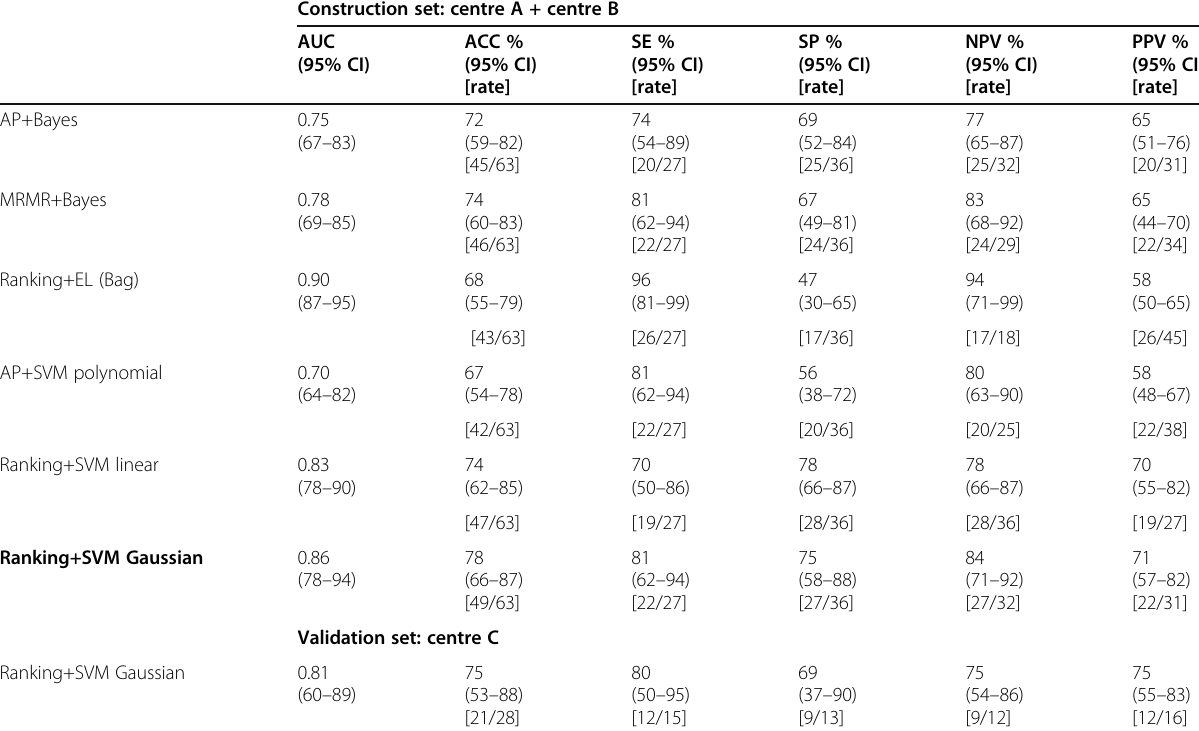
Table 4 Performances for the automatic